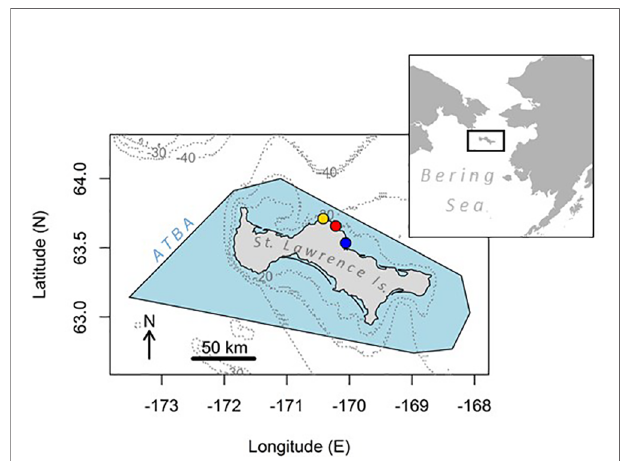
FIGURE 1 | Map of the study area showing St. Lawrence Island in the northern Bering Sea, surrounded by the Area To Be Avoided for shipping (ATBA, blue shade). Isobaths -20, -30 and -40 m are drawn in grey dotted lines. Study colonies are indicated with fi lled circles: from west to east: Kitnik (gold), Myughi (red), Tuqaghuk (blue).